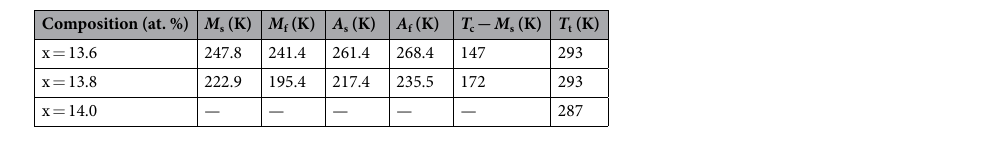
For equation (1), the fraction of martensite δ ∈ (0, 1) is positive during forward transformation whereas δ ∈ (0, − 1) is negative during reverse transformation. For x = 14.0, the application of a uniaxial compressive stress leads to a decreasing shift in the Gibbs free energy curve for martensite G M ( T ), which in turn results in a higher equivalent . When the input work (the temperature T 0 . Here, T 0 denotes the equilibrium temperature at which ∆ = ∆ G G ch ch A M applied compressive stress multiplied by the strain) is sufficiently large to overcome the energy barrier for forward